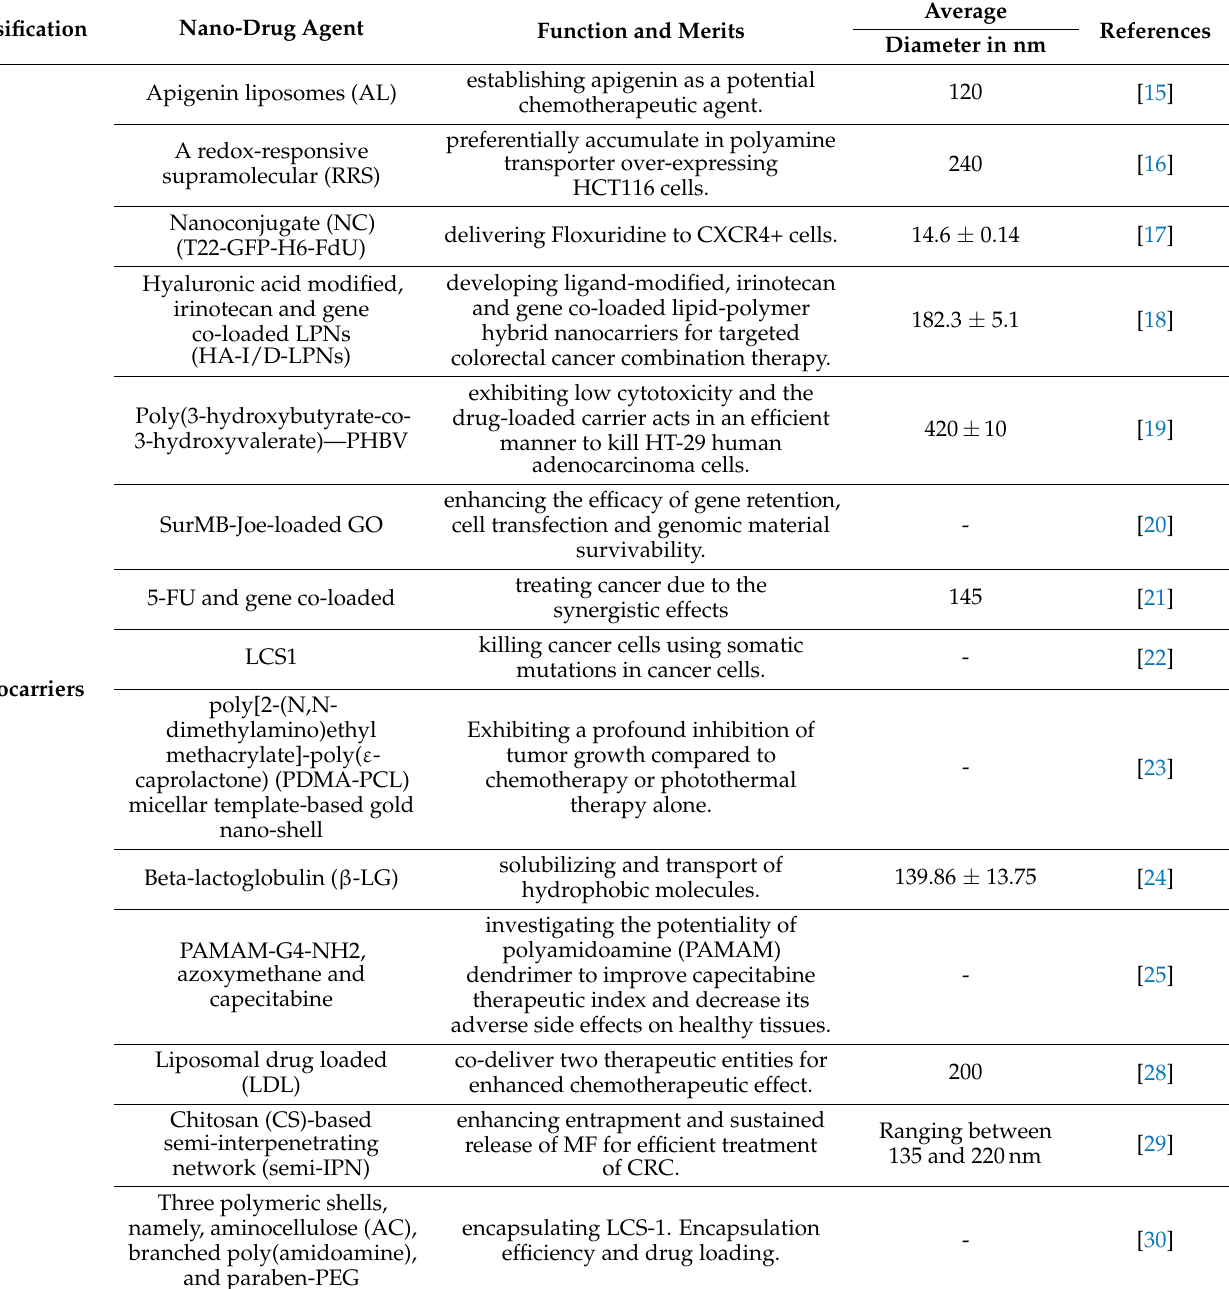
Table 1. A comparison between different types of molecules used in